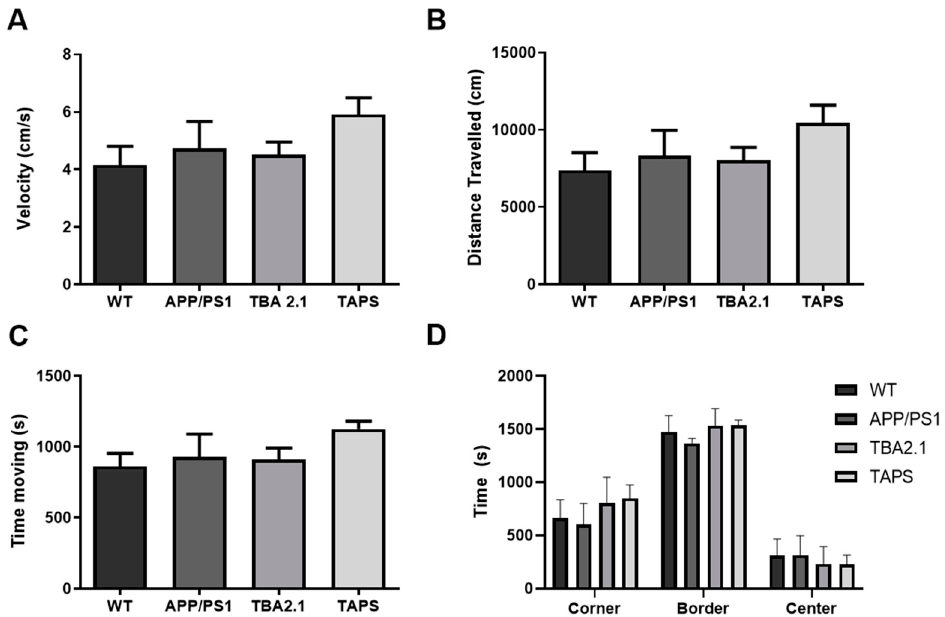
Figure 6. Performance of TAPS mice in the open field test. Wild-type (WT; n = 8), APP/PS1 ( n = 5), and TBA2.1 ( n = 8) showed similar velocity ( A ), distance traveled ( B ), and activity time ( C ) in the open field test. The TAPS mice ( n = 4) showed a trend to be faster, traveled more, and were more active compared to the WT. All mice stayed similar time in the border, center, and corner regions of the open field ( D ). Data is given as mean + SEM.